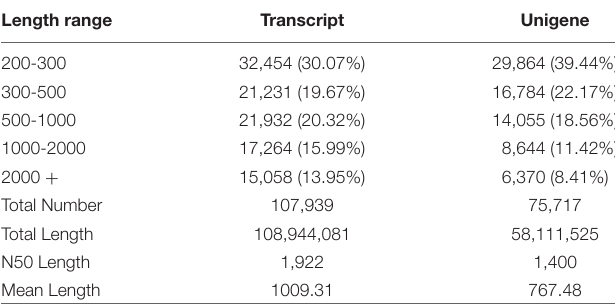
TABLE 2 | Sequencing data statistics.